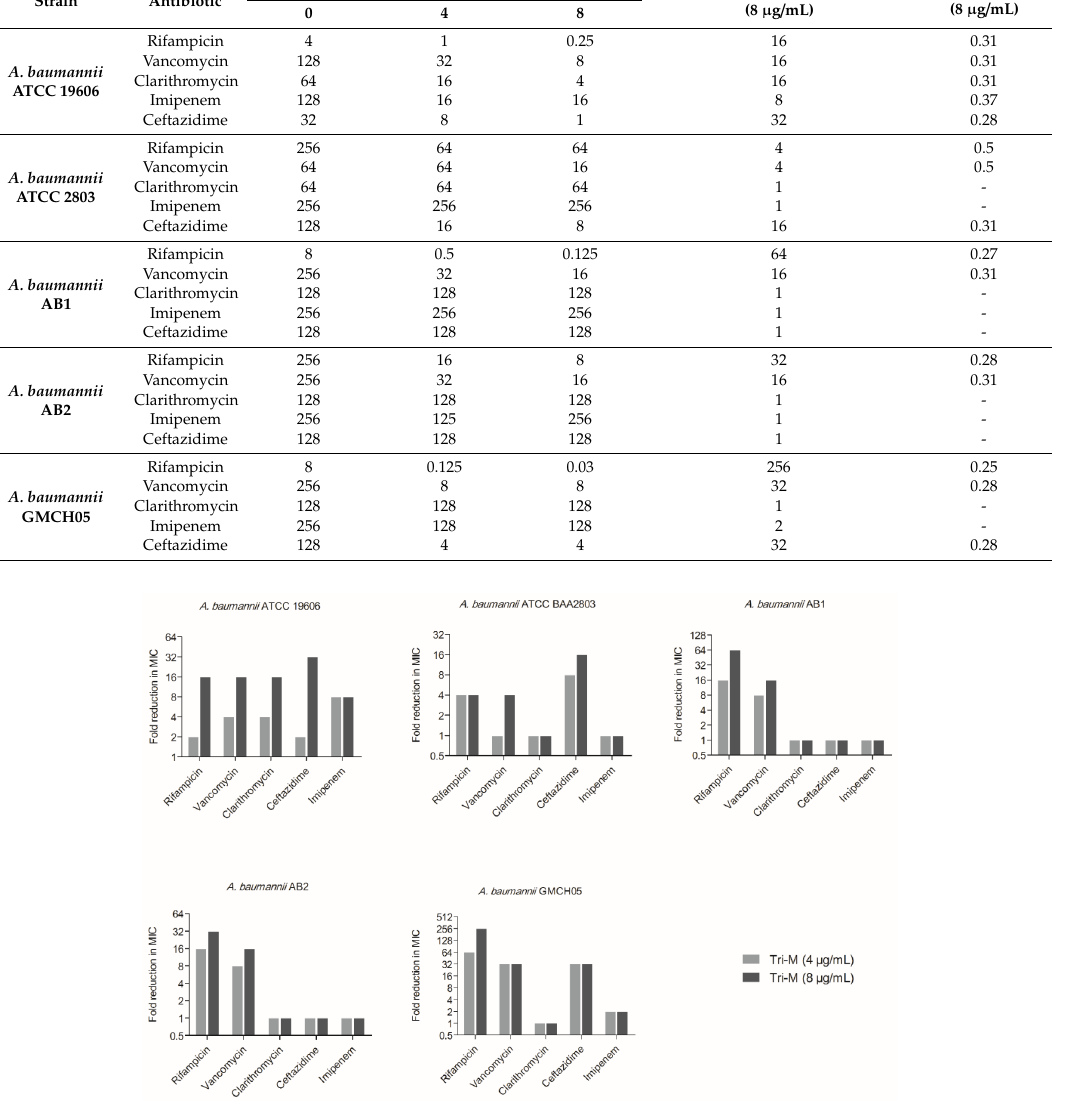
Table 2. Potentiation of various antibiotics in the presence of tridecaptin M in di ff erent A. baumannii strains. Strain